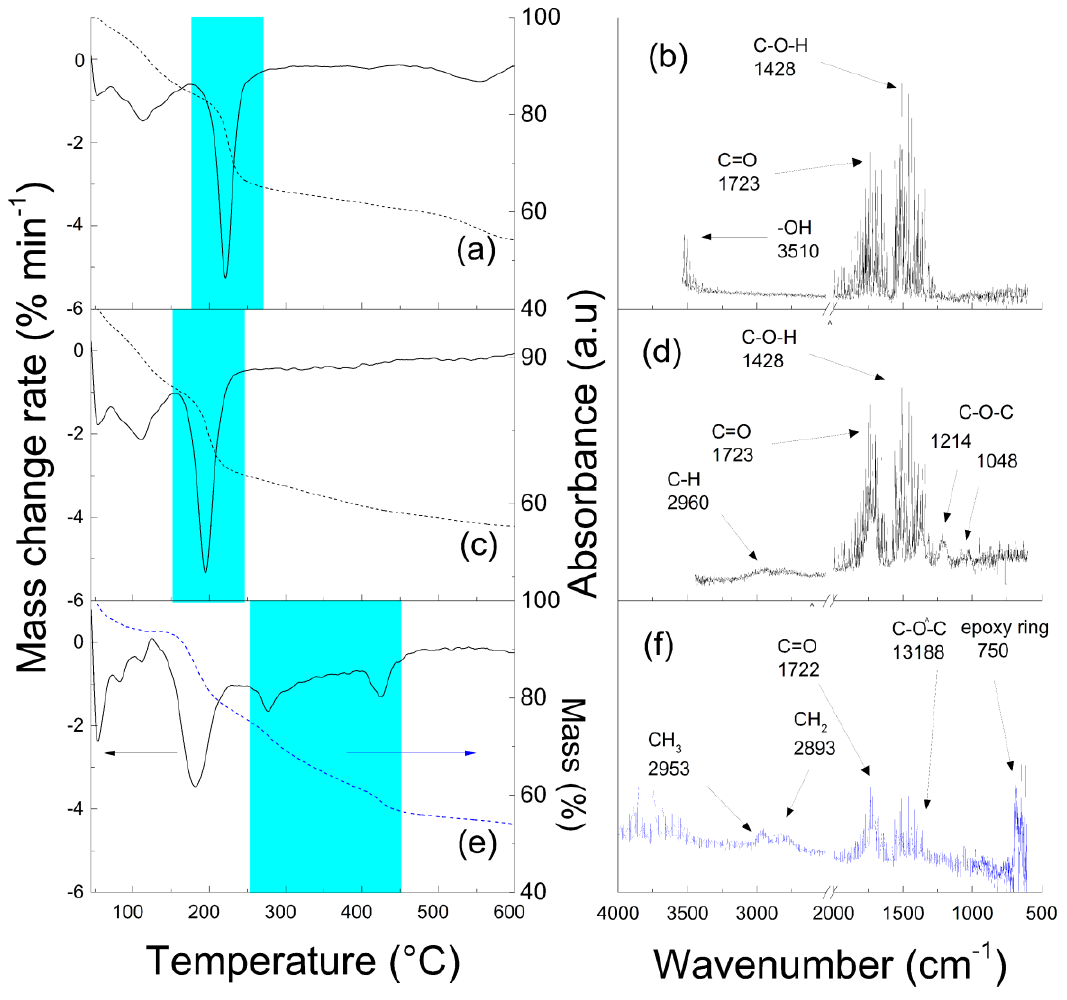
Figure 3. TGA analysis ( a , c , e ) with on-line monitoring of the FTIR spectra ( b , d , f ) for neat GO ( a , b ); GO-iniciator, and ( c , d ) and GO-PGMA ( e , f ) particles.